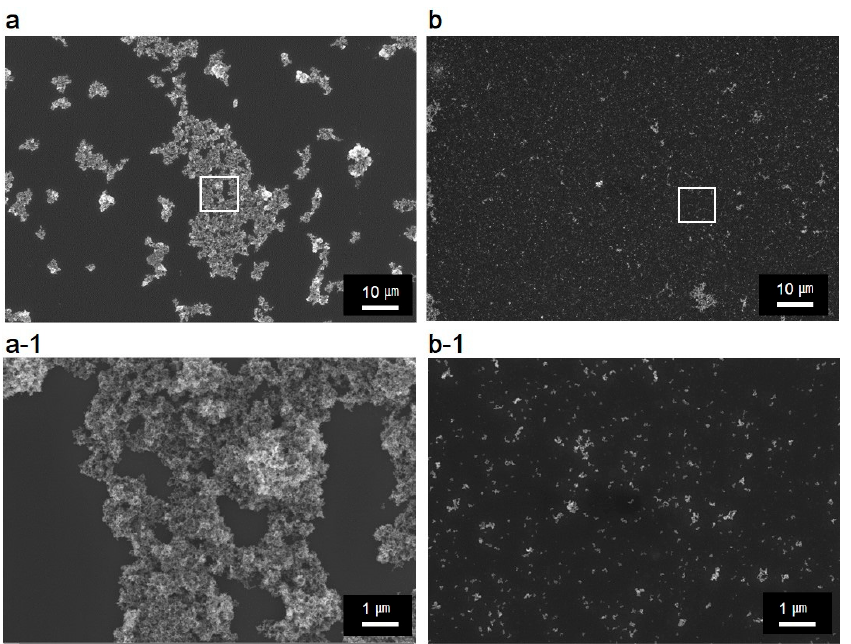
Figure 6. SEM images before ( a ) and after ( b ) ultrasonic dispersion. ( a-1 ) and ( b-1 ) represent the magnified images of the regions marked in white boxes in ( a ) and ( b ), respectively.